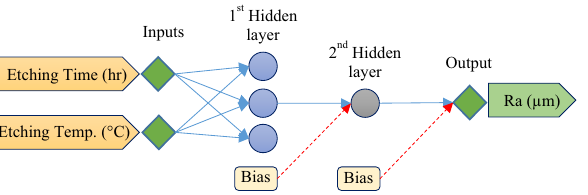
Figure 5. A schematic of the ANN model structure for R a prediction based on etching time and etching ambient temperature.